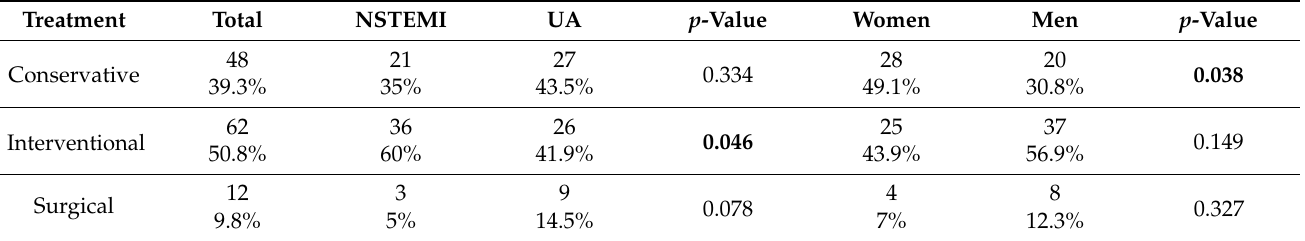
Table 4. Treatment options and Chi-square test